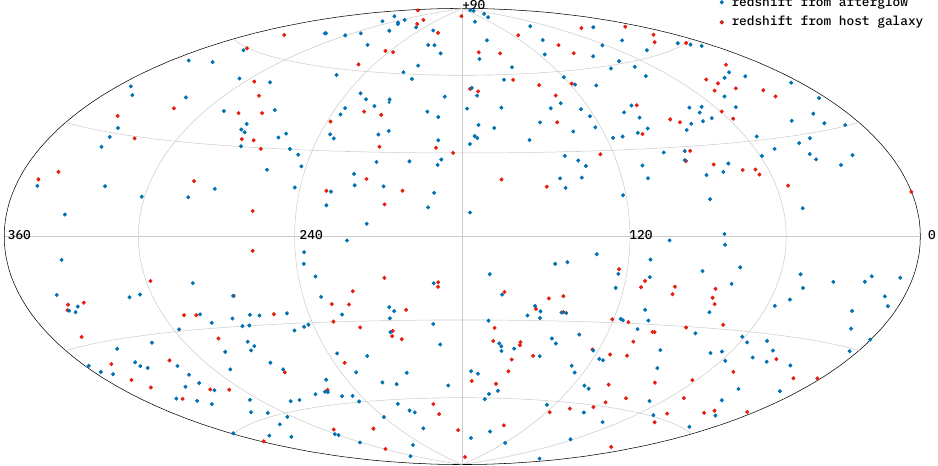
Figure 1. Galactic distribution of 522 GRBs with measured spectroscopic redshift till 4 June 2021. The disk of the Galaxy hinders the optical follow-up. The blue/red colors mark the afterglow/host galaxy origin of the